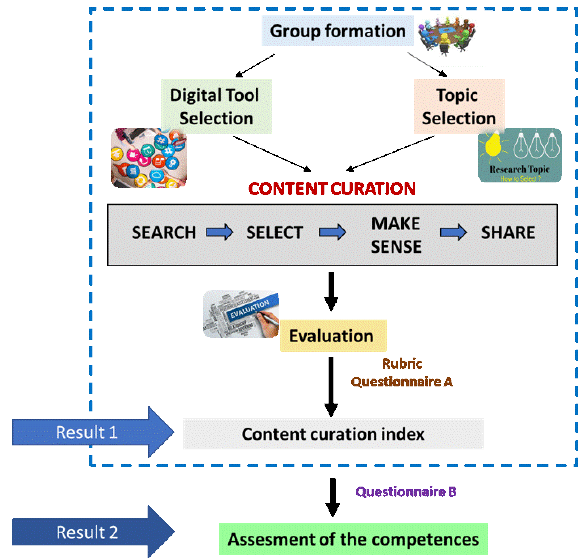
Figure 1. Methodology. Figure 1.